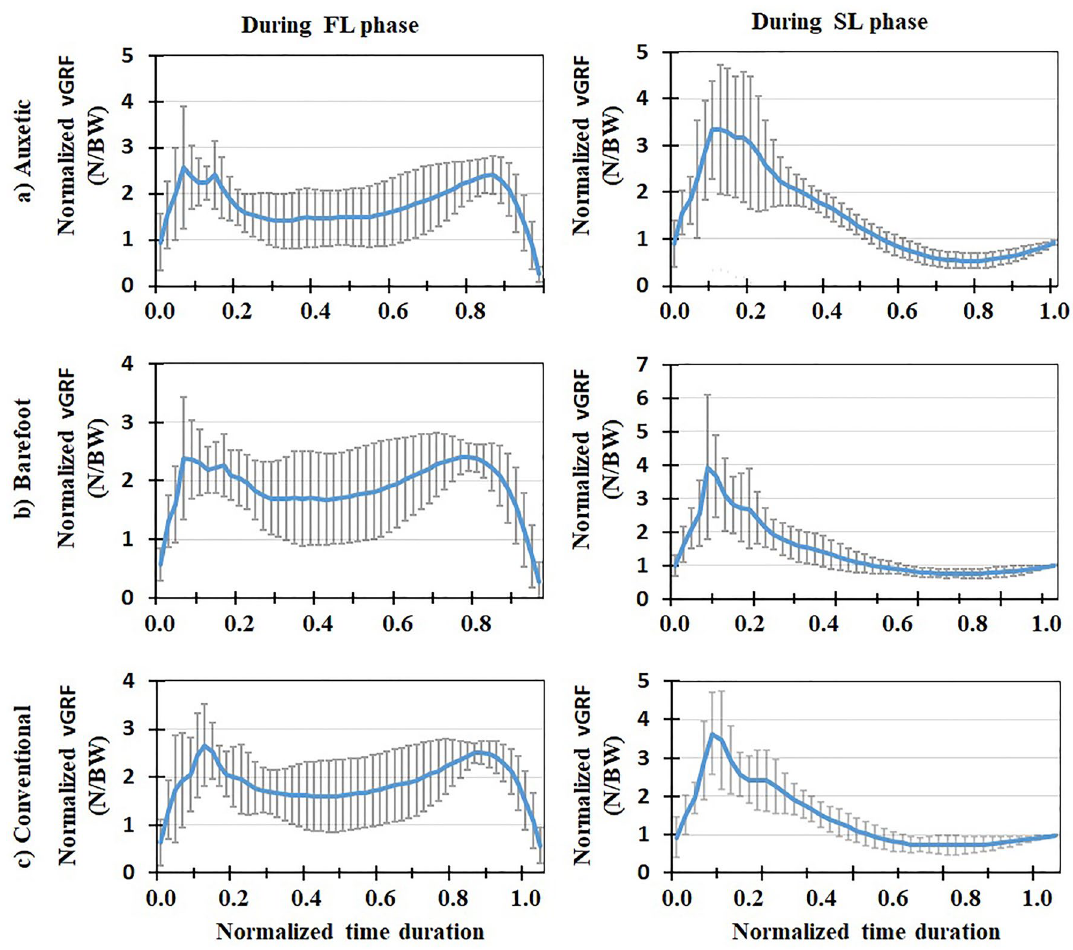
Figure 3. Mean normalized vGRF (N/BW) for all the participants (+ / − one standard deviation) in three footwear conditions: ( a ) auxetic shoe, ( b ) barefoot, and ( c ) conventional shoe. Left and right plots indicate variations during FL and SL phases of DVJ,